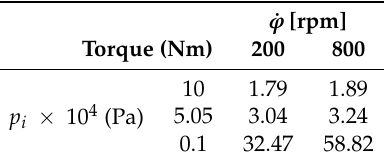
Table 6. Ratio of the aerodynamic torque in the free configuration and the in housing configuration, for different rotational speeds and depressions in the sealed container. Absolute values are shown in Figure 9.